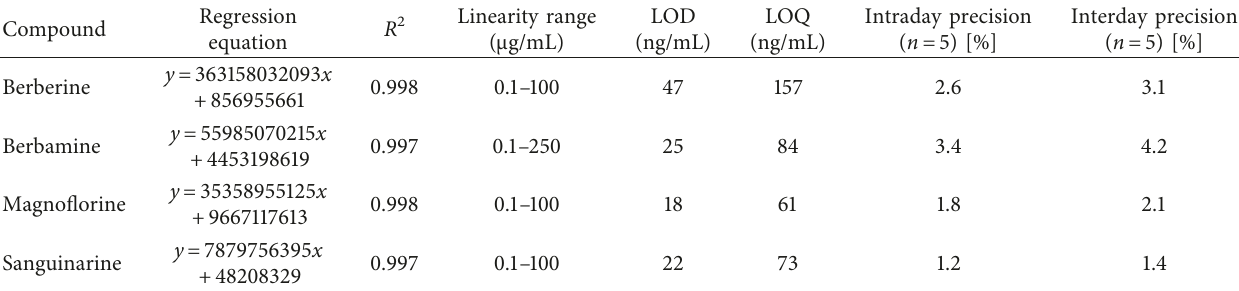
Table 3: Method validation parameters for the studied model alkaloids: linearity, precision, limits of detection, and quantification. Compound